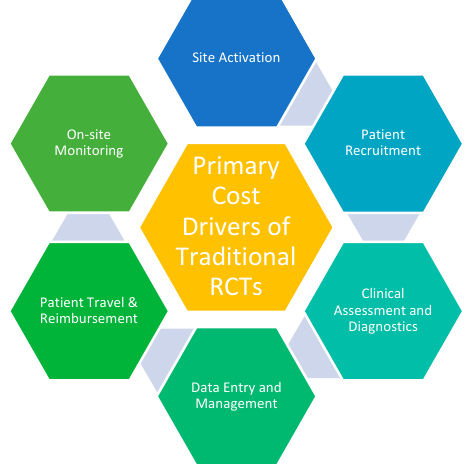
Figure 1. Primary cost drivers of traditional RCTs.